Question: Looking at the figure, what chart type is it?
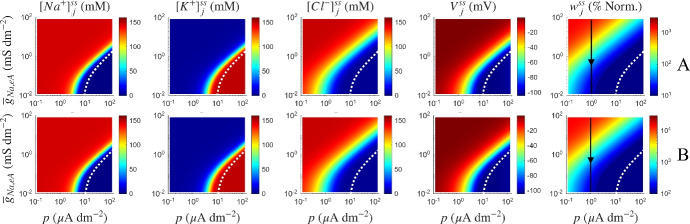
Answer: heatmap